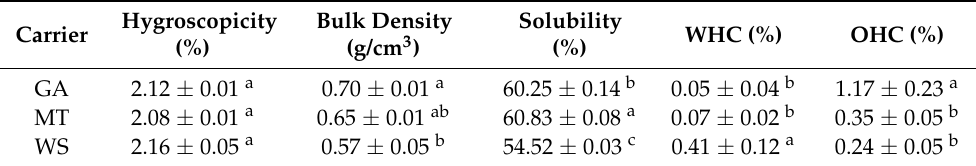
Table 3. Hygroscopicity, bulk density, solubility, water holding capacity, and oil holding capacity, of freeze-dried raspberry juice powders developed using different carriers. Carrier